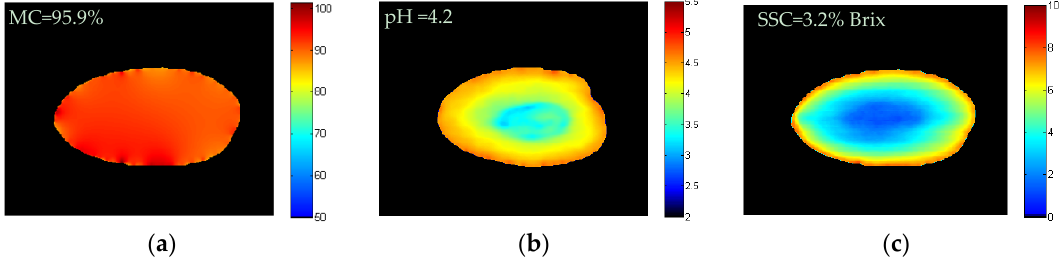
Figure 7. Prediction maps for tomato quality parameter ( a ) moisture content, ( b ) pH and ( c ) soluble solid content (SSC).